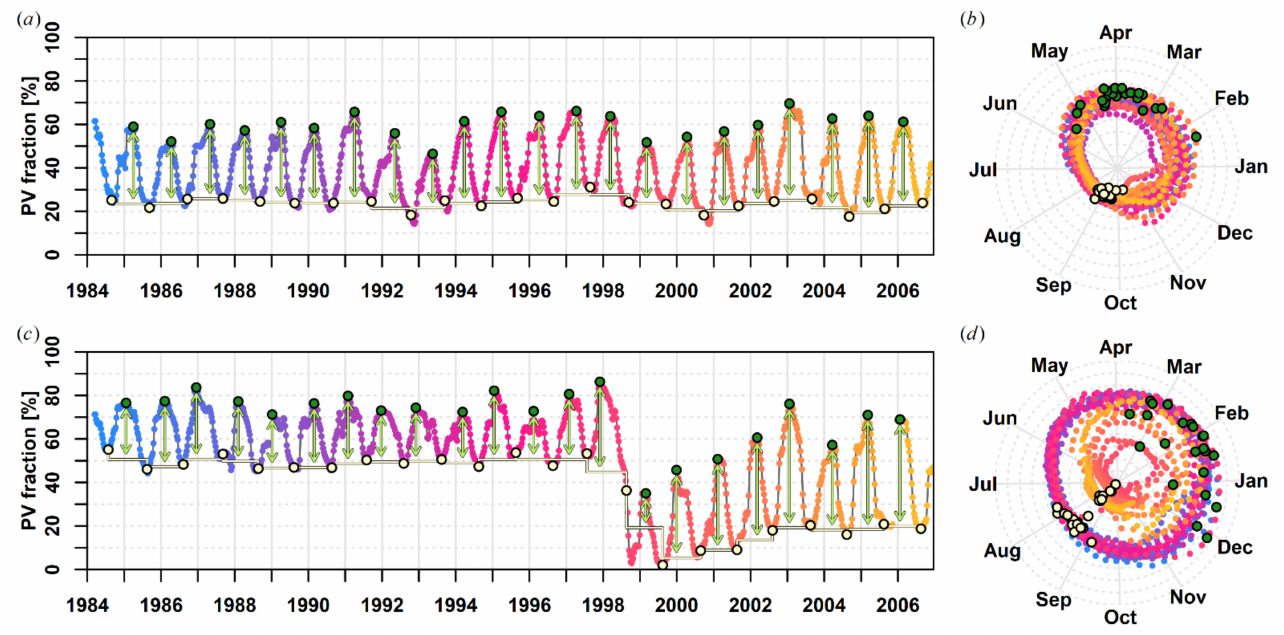
Figure 3. Fractional cover time series for two selected pixels. ( a , b ) Mixture of rock, grass, and shrub surfaces (35.36 ◦ N, 24.92 ◦ E); ( c , d ) mixture of rock and grass surfaces, with a higher share of woody vegetation before disturbance (35.29 ◦ N, 24.96 ◦ E). ( a , c ) Time-series plotted as a temporal sequence; ( b , d ) time series plotted in polar space; the grey isolines match the 10% fraction increments shown as horizontal lines in ( a , c ). The color-coding is consistent between related plots and shows the interpolated time series. Green circles represent the value of peak of season (VPS) metric; white circles represent the beginning/end of the phenological years θ s ; the lines in between represent the value of base-level (VBL) metric; the arrows represent the value of seasonal amplitude (VSA)